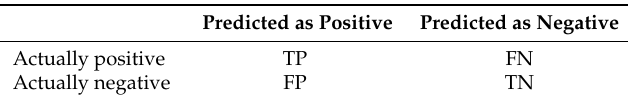
Table 3. Confusion